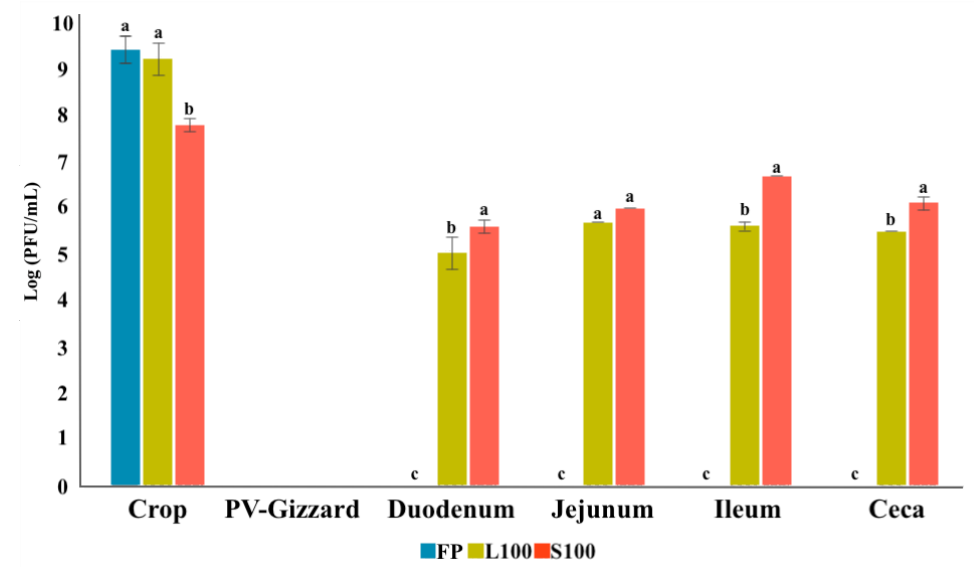
Figure 3. Amount of BP that remains in the supernatant whilst transiting across the simulated chicken GIT. Values are presented in Log10 (PFU/mL). FP: free BP; L100: encapsulated BP with the polymer Eudragit ® L100; S100: encapsulated BP with the polymer Eudragit ® S100; PV: Proventriculus. Error bars show one standard deviation. a,b,c : different letters indicate statistically significant differences between groups in the count of BPs that released and survives throughout the simulated GIT at p < 0.05.